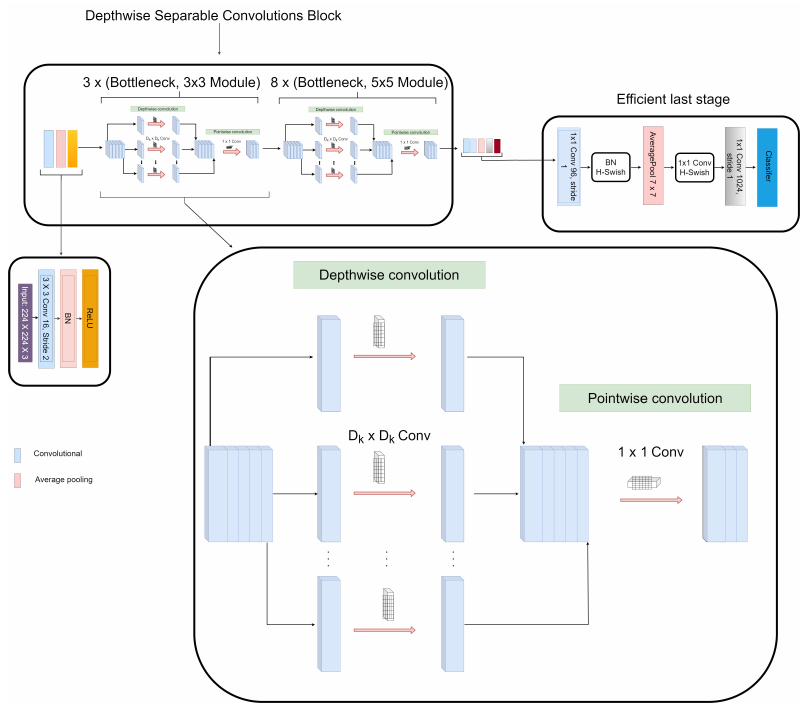
Figure 4. Detailed structure of our proposed depthwise separable convolution module.